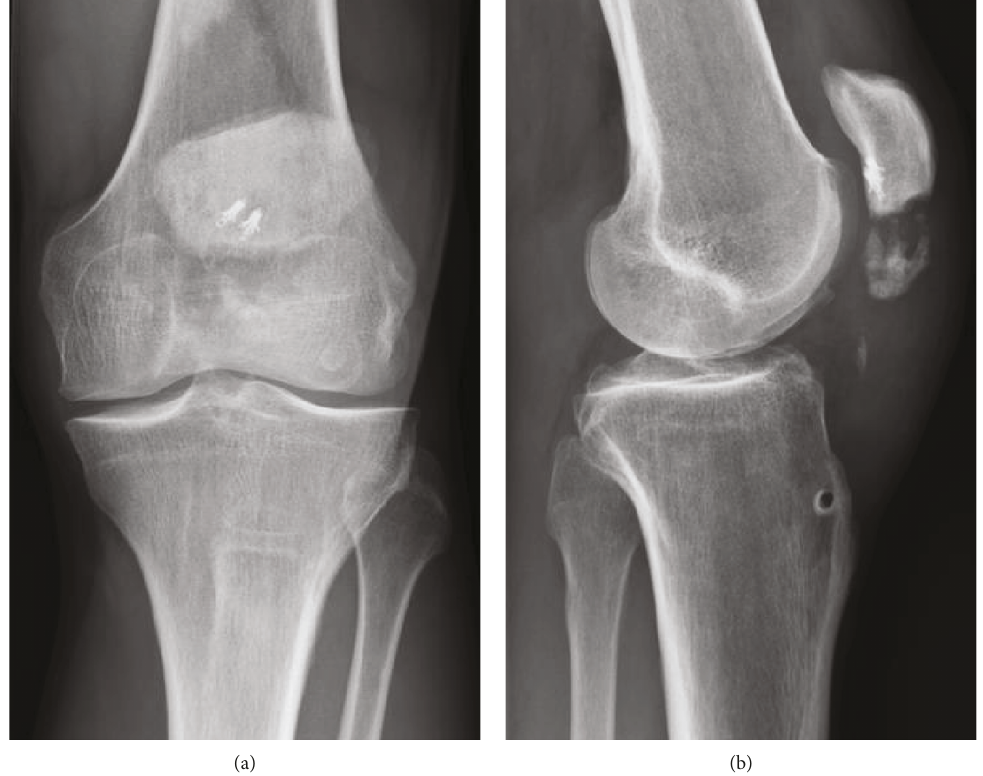
Figure 1: (a) Anteroposterior and (b) sagittal preoperative X-rays before the revision surgery. The iterative rupture of the extensor mechanism is explained by the fracture of the transverse patellar tunnel drilled during the initial surgery to pass the semitendinosus graft.